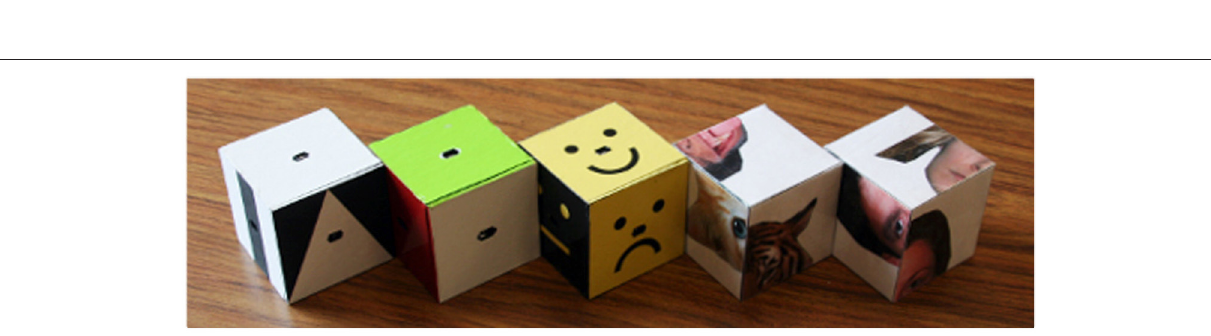
FIGURE 3 | SIG-Block cover images: For children’s TAG-Games, in addition to the geometric shapes and color blocks used in our preliminary study, SIG-Blocks with segmented human and animal face images and emoticons were also used. C play values are calculated by the formula shown in Equation (1).